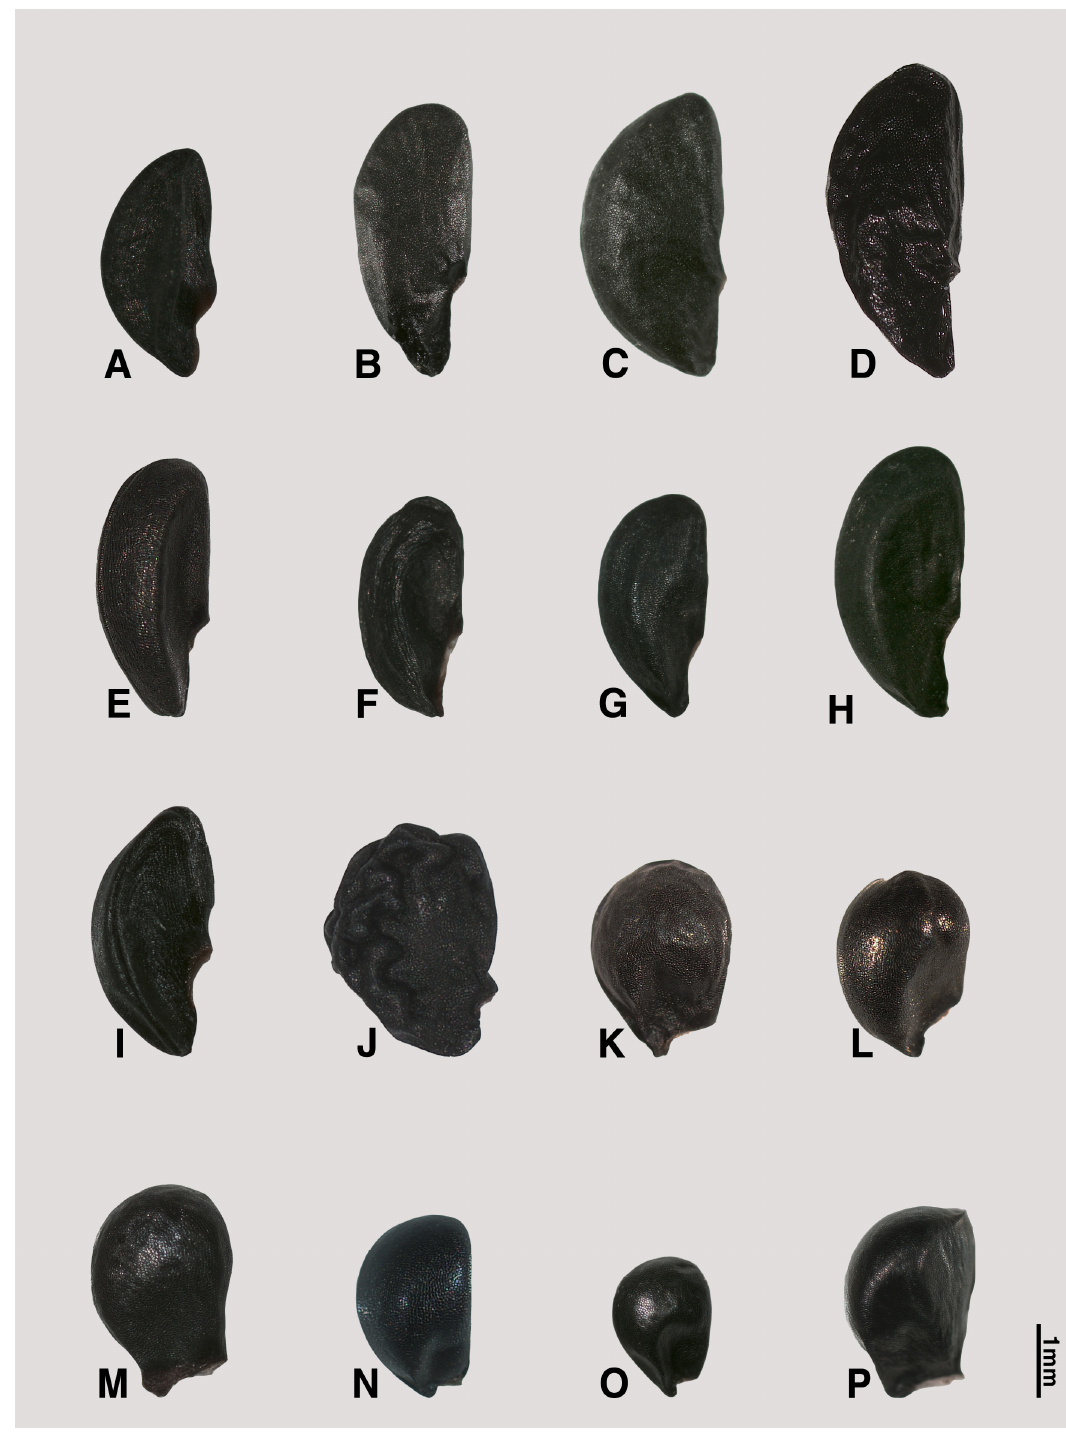
Figure 3. Various shapes of seed in Allium . ( A ) A. kirilowii (sect. Falcatifolia , subg. Polyprason ); ( B – J ) subg. Reticulatobulbosa : ( B ) A. barsczewskii ; ( C ) A. dolichostylum ; ( D ) A. jodanthum (sect. Campanulata ); ( E ) A. amphibolum ; ( F ) A. clathratum ; ( G ) A. leucocephalum ; ( H ) A. malyschevii , ( I ) A. strictum (sect. Reticulatobulbosa ); ( J ) A. trachyscordum (sect. Scabriscapa ); ( K – P ) subg. Rhizirideum : ( K ) A. bidentatum ; ( L ) A. polyrhizum (sect. Caespitosoprason ); ( M ) A. austrosibiricum (sect. Rhizirideum ); ( N ) A. anisopodium ; ( O ) A. tenuissimum ; ( P ) A. vodopjanovae (sect. Tenuissima